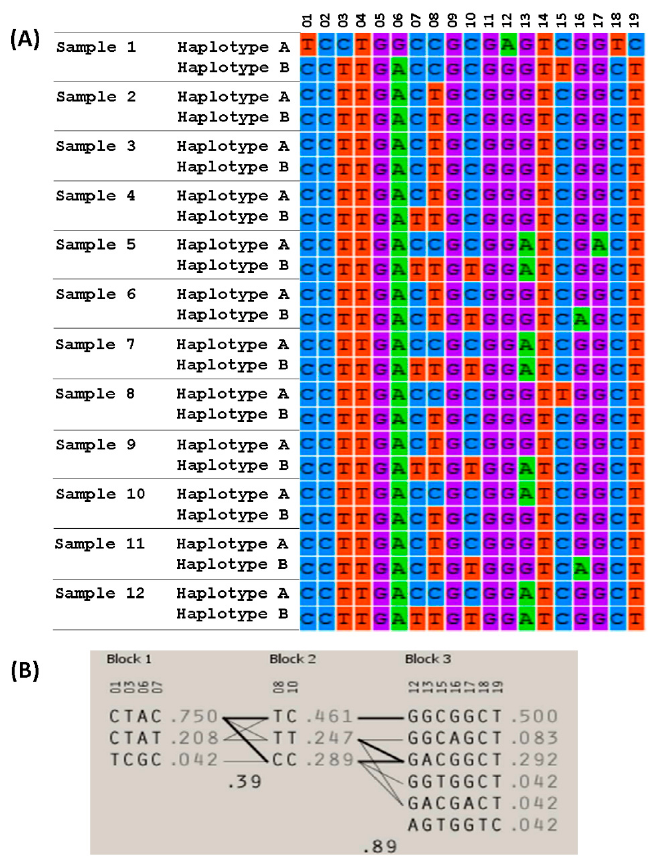
Figure 3. Inferred haplotypes for LHCGR gene. Panel ( A ) shows the 12 samples analyzed and their two inferred haplotypes, panel ( B ) shows the haplotype blocks and their frequencies.